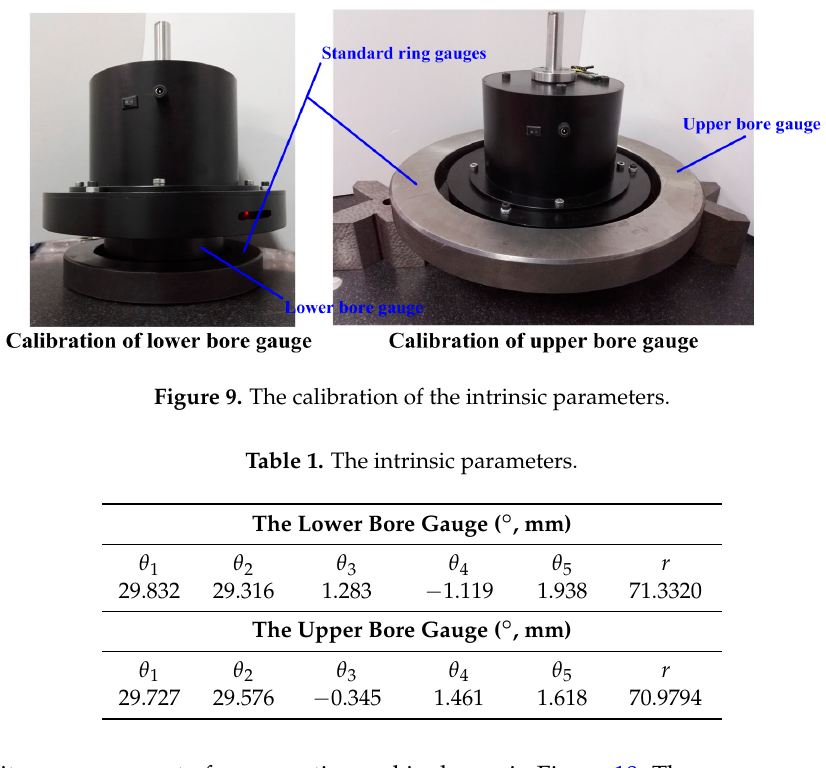
Figure 8. The actual measurement of the connecting rod.